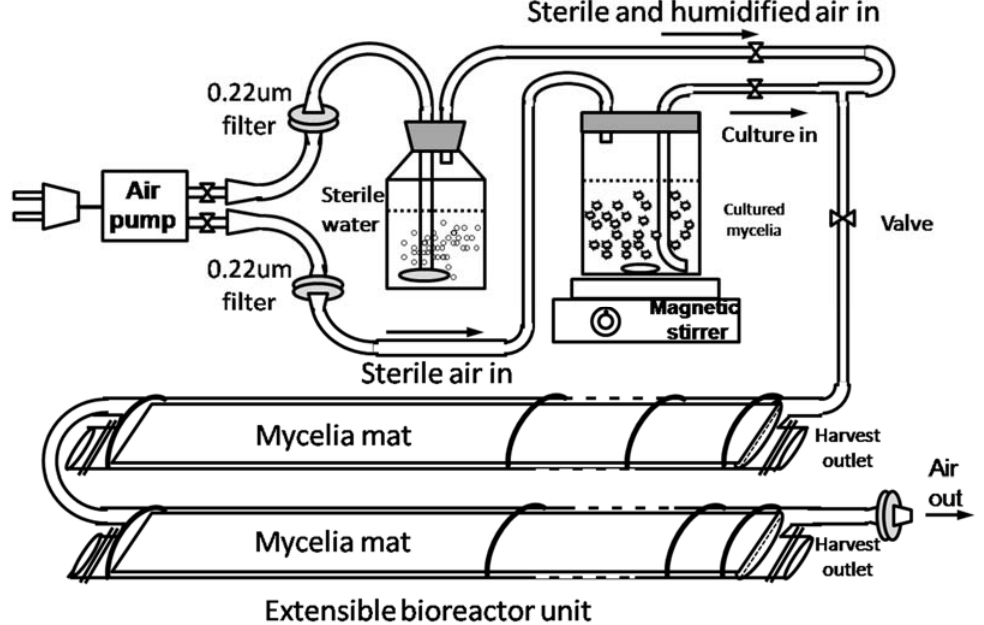
Figure 8. Illustration of designed plastic bag shaped extensible static bioreactor.